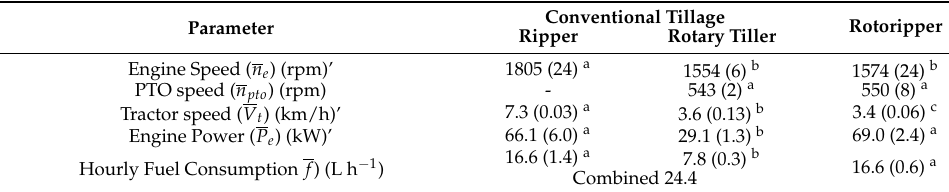
Table 3. Mean values of the performance parameters obtained during the passes, standard deviations in brackets. Means with the same apex letter (a, b or c) on the same row do not differ statistically ( p > 0.05) by the ANOVA